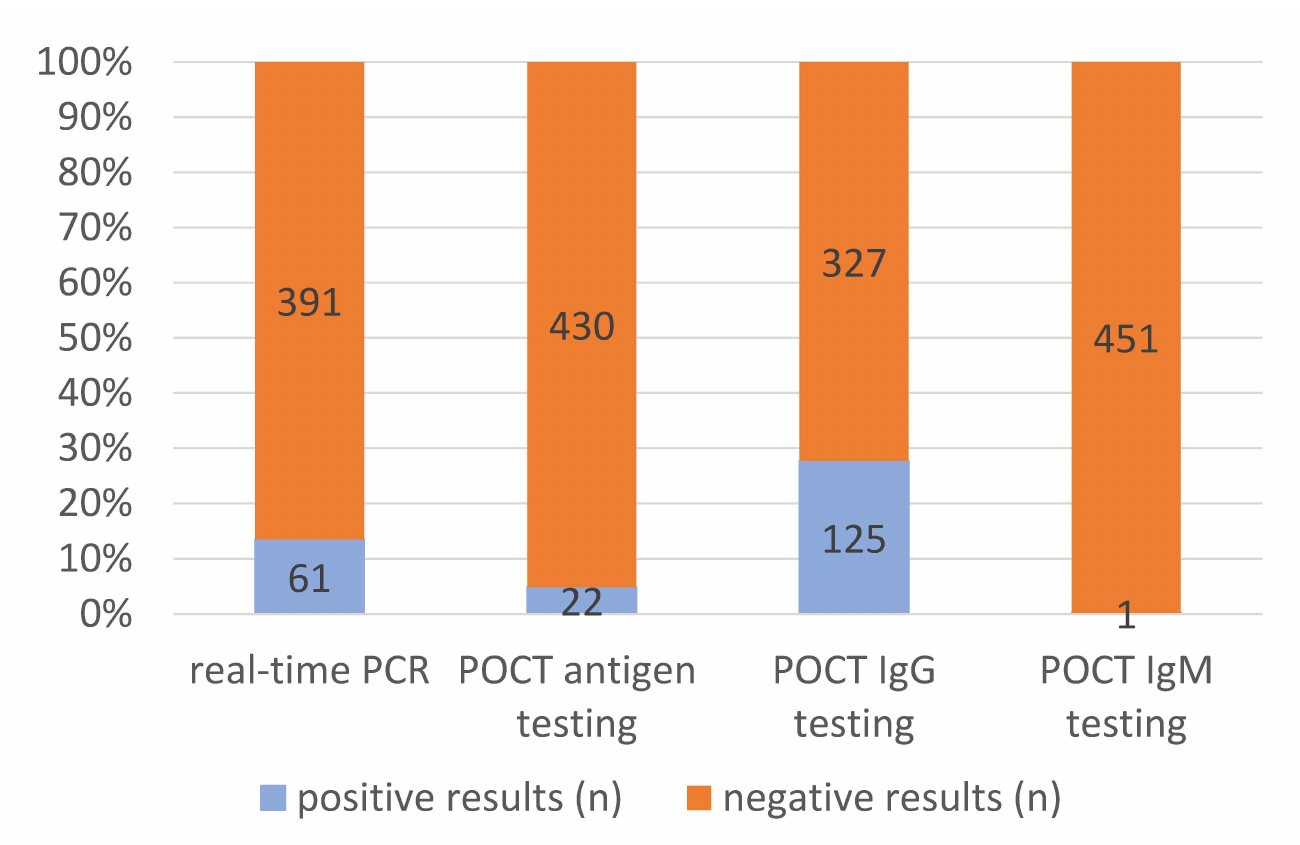
Figure 1. Numbers and proportions of positive test